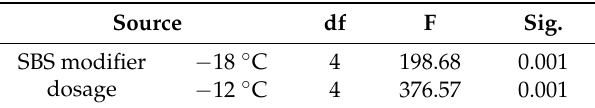
Table 8. Variance analysis for S(t) of SBS modified asphalt. 237